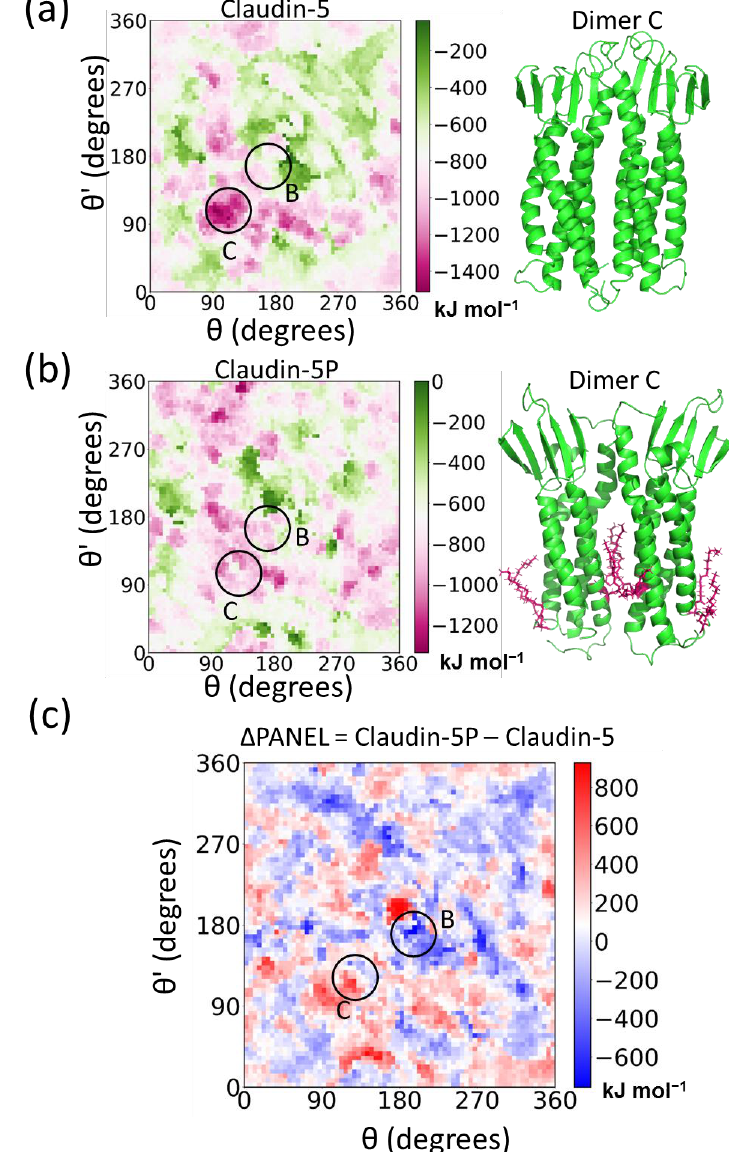
Figure 9. Effects of palmitoylation on claudin-5 cis dimerization. ( a ) PANEL plot Figure claudin. and dimer C conformation (green ribbon), ( b ) PANEL plot for claudin-5P and dimer C conformation (green ribbon) with palmitoylation (pink sticks), and ( c ) ∆ PANEL showing the difference in stability upon palmitoylation. The location of dimers B and C are marked by circles (black) on all plots.